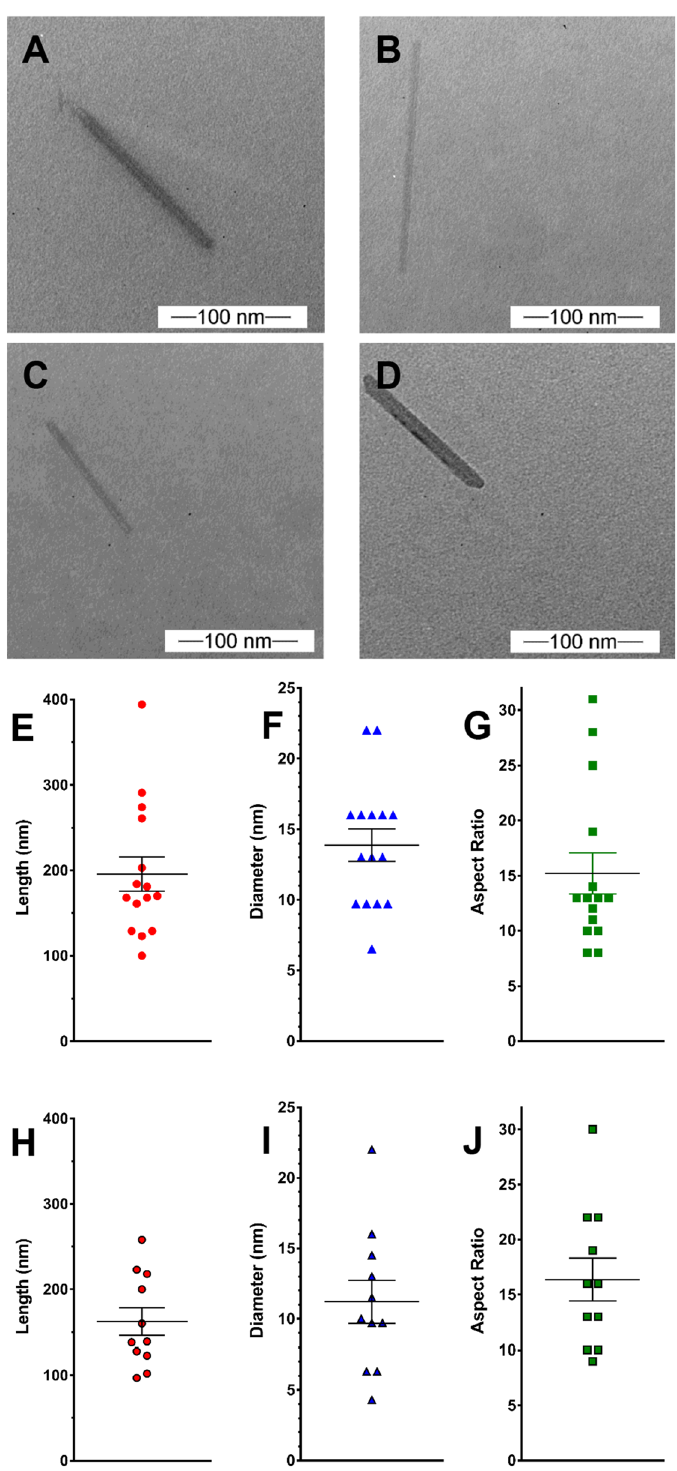
Figure 2. Representative TEM images of pristine CNC ( A,B ) and fCNC ( C,D ) show linear molecular shapes for both the starting material and the product. The characteristic high aspect ratio and rigid linear shape of the starting material is preserved following the functionalization procedures. Analysis of pristine CNC particle length ( E ), diameter ( F ), and aspect ratio ( G ) shows a length of 195.7 ± 20.2 nm, diameter of 13.9 ± 1.16 nm, and aspect ratio of 15.2 ± 1.87 (mean ± SEM, n = 15). Analysis of fCNC particle length ( H ), diameter ( I ), and aspect ratio ( J ) shows a length of 162.4 ± 16.3 nm, diameter of 11.2 ± 1.52 nm, and aspect ratio of 16.4 ± 1.94 (mean ± SEM, n =